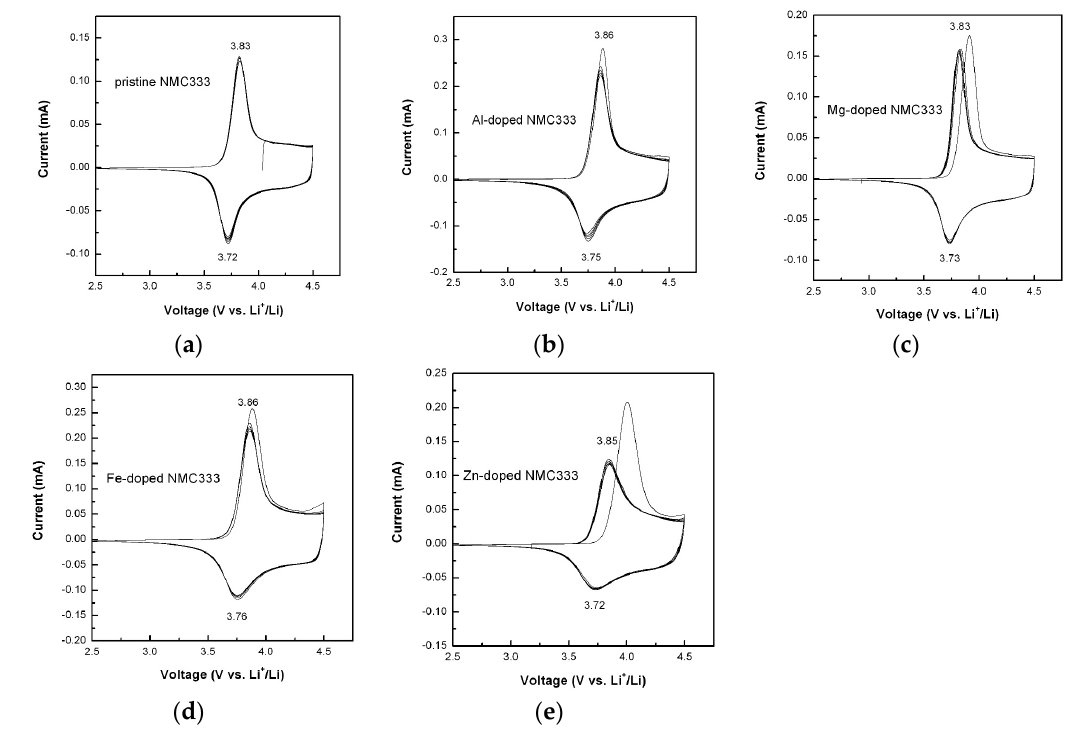
Figure 7. Cyclic voltammograms of parent ( a ) and doped LiNi 1/3 Mn 1/3 Co 1/3 O 2 with Al ( b ), Mg ( c ), Fe ( d ) and Zn ( e ) at a sweep rate of 0.05 mV s − 1 between 2.5 and 4.5 V versus Li + /Li 0 . Table 3. The oxidation ( E pa ) and reduction ( E pc ) peak potential and the corresponding di ff erence ∆ E